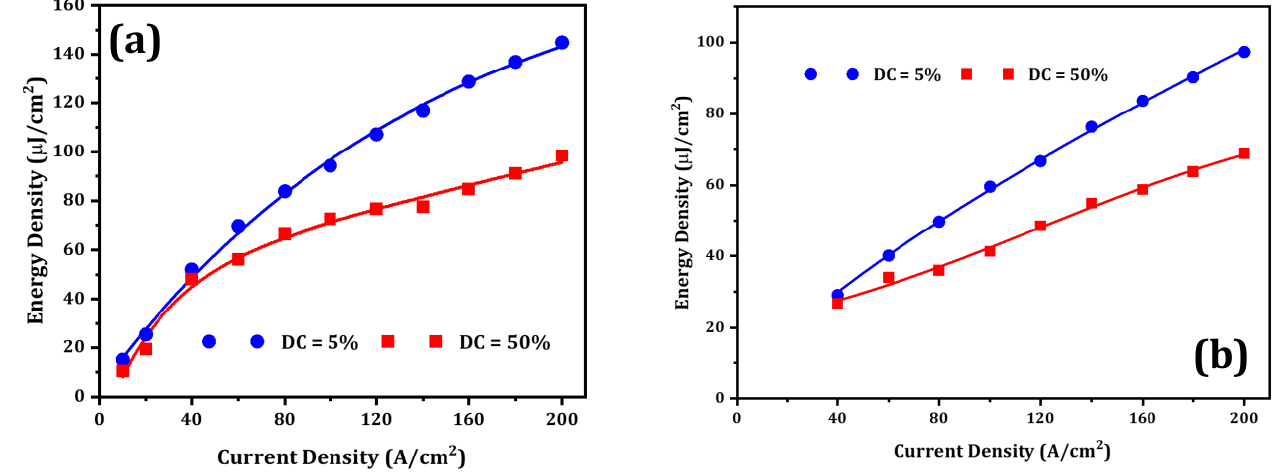
Figure 4. Measures optical energy density at different duty cycles (DC) for ( a ) commercial μ-LEDs and ( b ) μ-LED from this work.